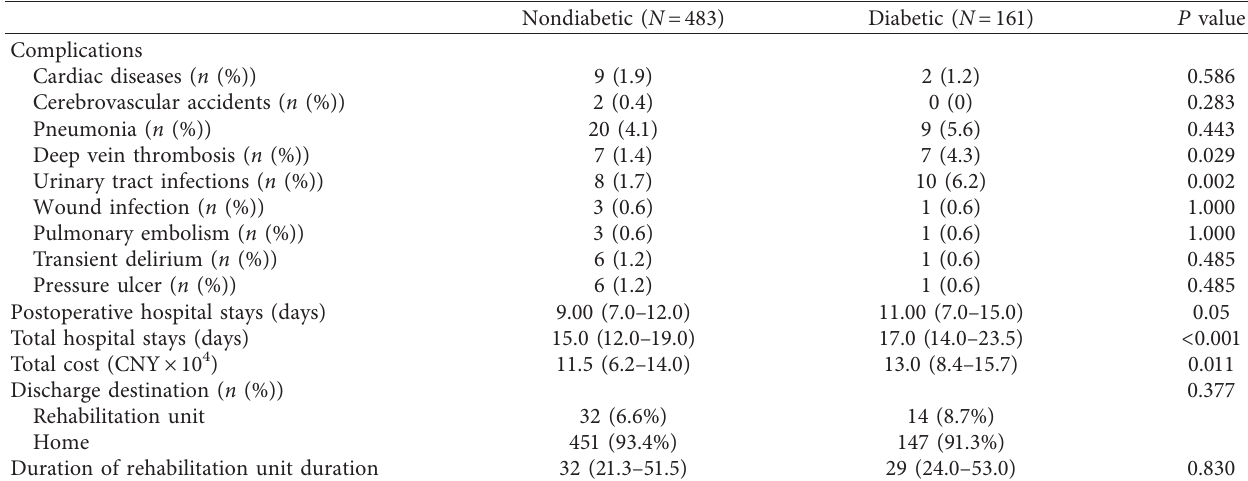
Table 2: Comparison of short-term outcome after fracture in the two groups of patients.